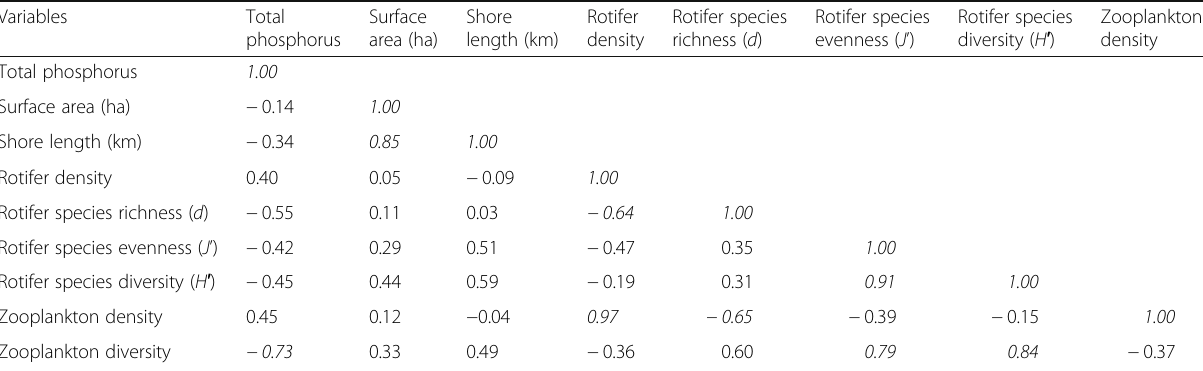
Table 3 Spearman correlation matrix of zooplankton and environmental parameters Variables